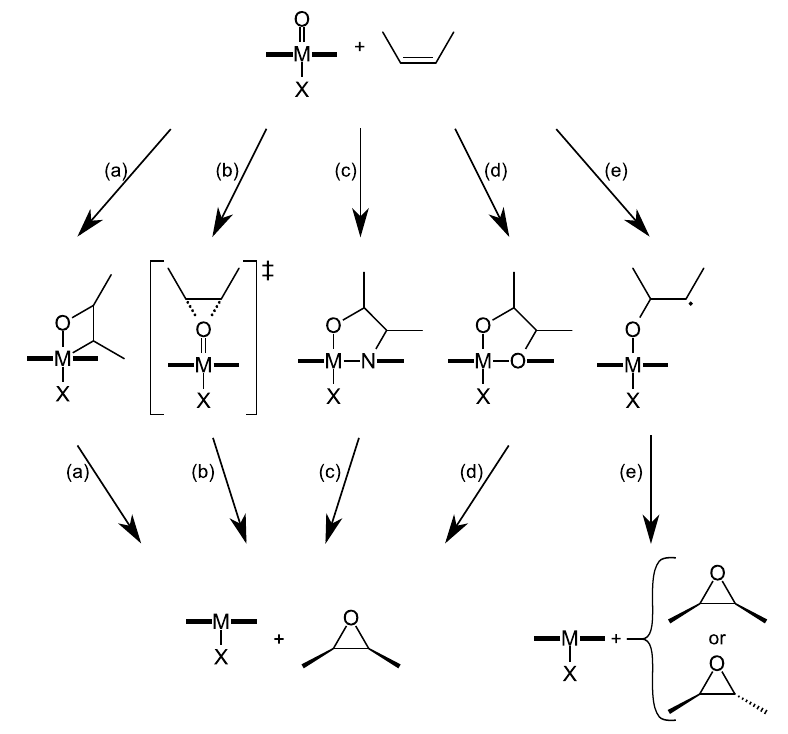
Figure 4. Generic representations of the most commonly-studied reaction paths for the oxygen atom transfer between oxo-manganese and oxo-iron complexes and a cis -alkene: metallaoxethane intermediate ( a ); concerted transition state ( b ); five-member ring intermediate using a nitrogen ( c ) or oxygen ( d ) from the main ligand; or via a carbon radical intermediate ( e